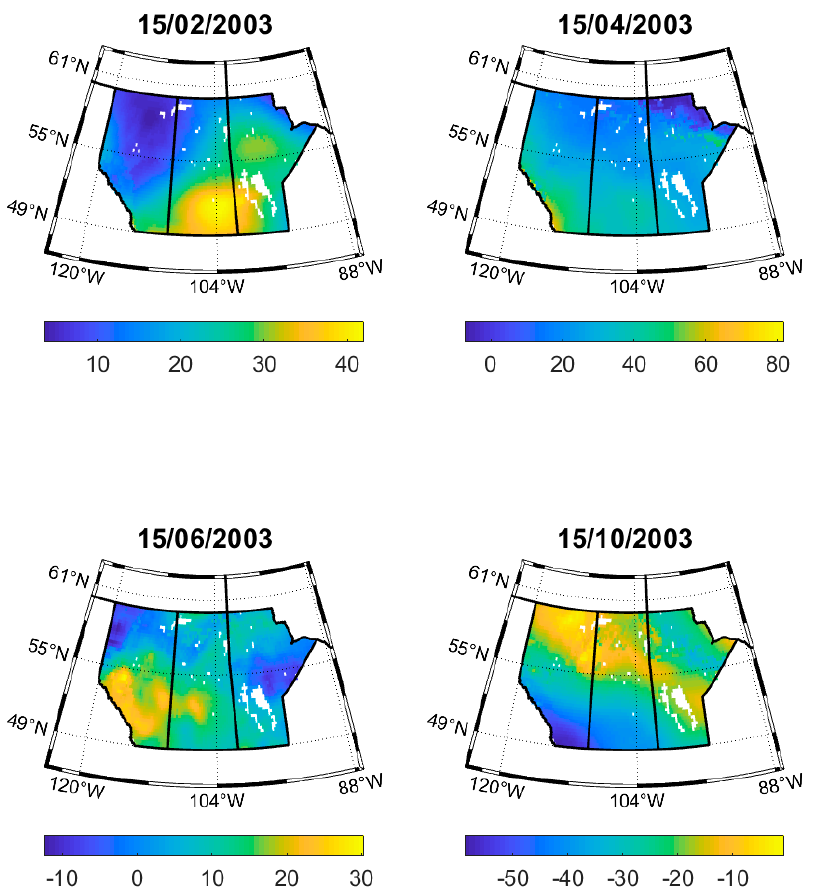
Figure 11. Downscaled GRACE groundwater storage anomalies (GWSA) over the study area on the 15th day of each selected month with separate colour bar ranges [mm].